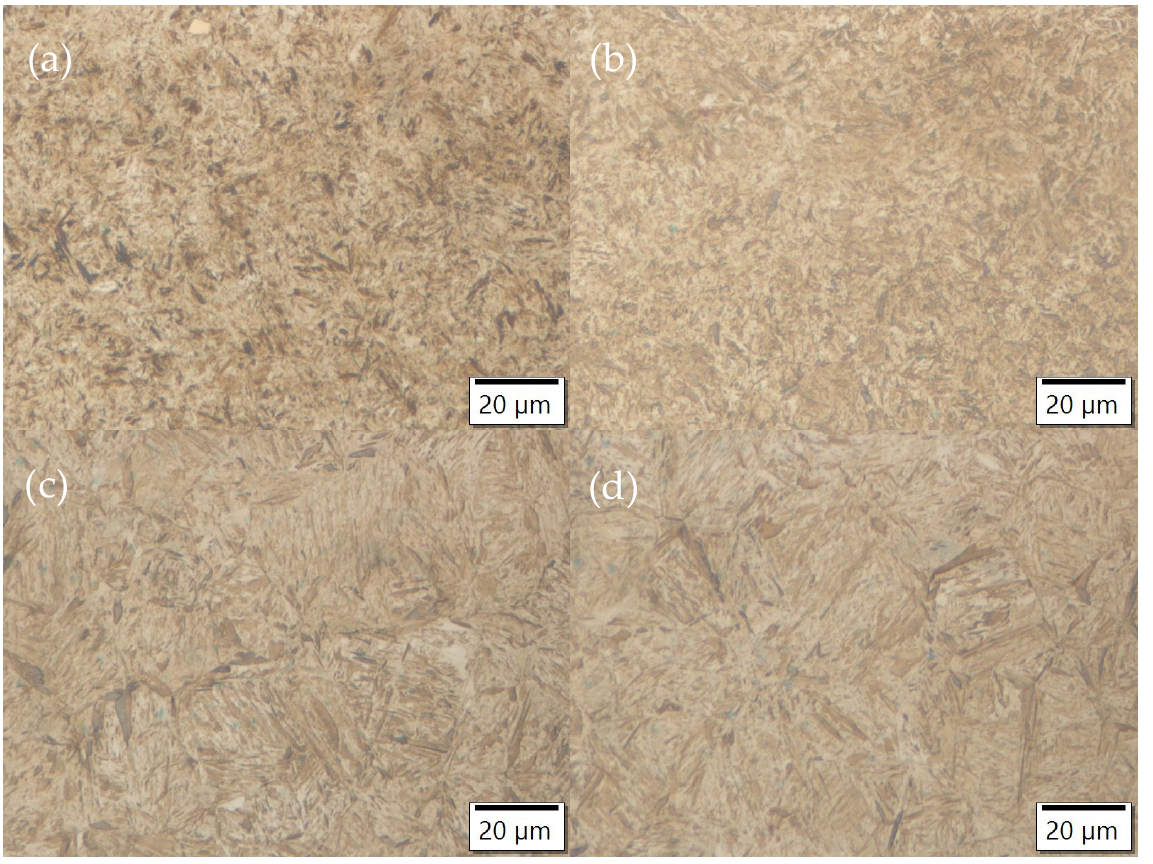
Figure 6. The microstructures of etched, quenched samples ( a ) 800 °C ‐ 5 min, ( b ) 800 °C ‐ 30 min, ( c )